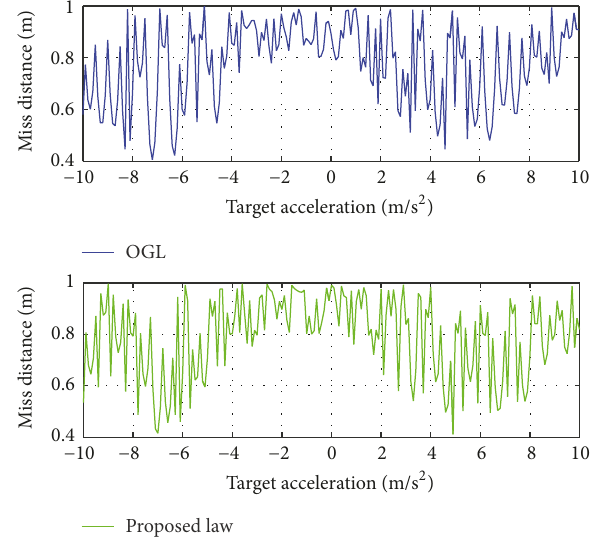
Figure 12: Max look angle of OGL and proposed law under different acceleration of target.